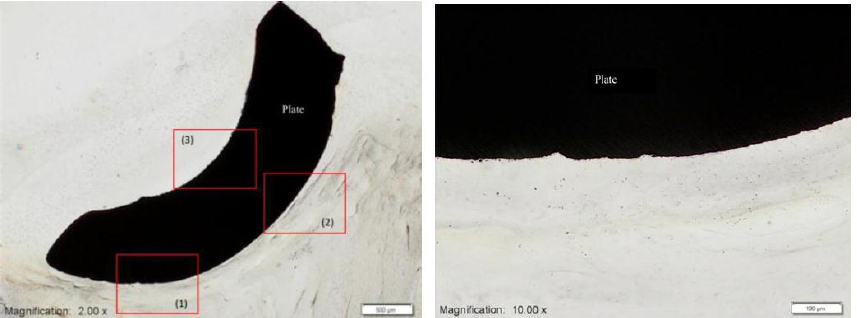
Figure 7. Micrograph showing surrounding tissue on the MIM Ti-64 implant showing continuous contact